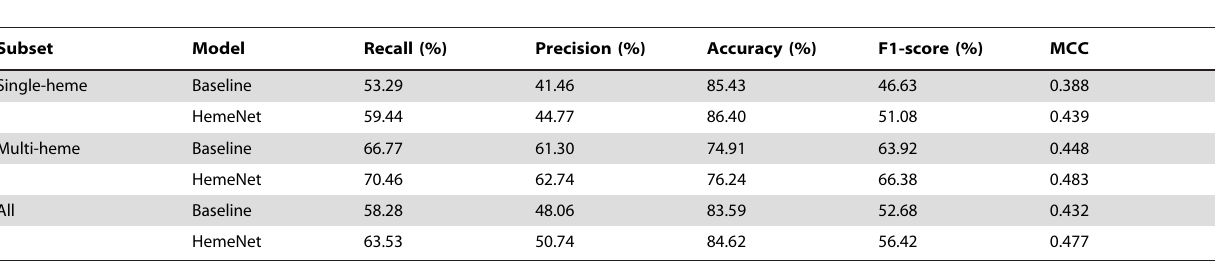
Table 4. Performance of baseline model and HemeNet tested on Dataset